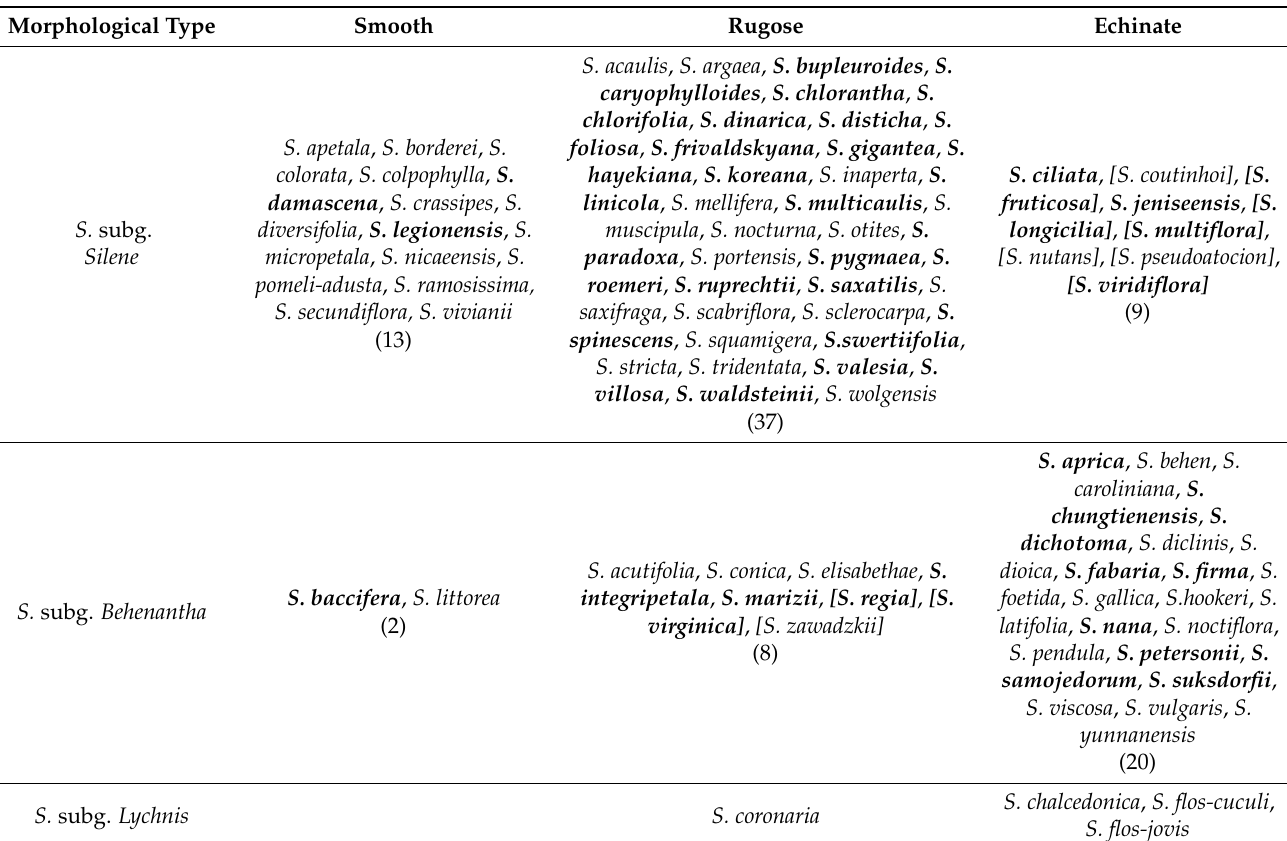
Table A1. Adscription of the species belonging to the three main morphological groups to the subgenera of Silene . The species with papillose seeds belong to S. subgen. Silene ( S. perlmanii ) and S. subgen. Behenantha ( S. holzmanii , S. laciniata and S. magellanica ). The species between brackets belong to S. sect. Siphonomorpha and S. sect. Physolychnis . The species written in normal format were analyzed in [30] while those written in bold belong to this work.